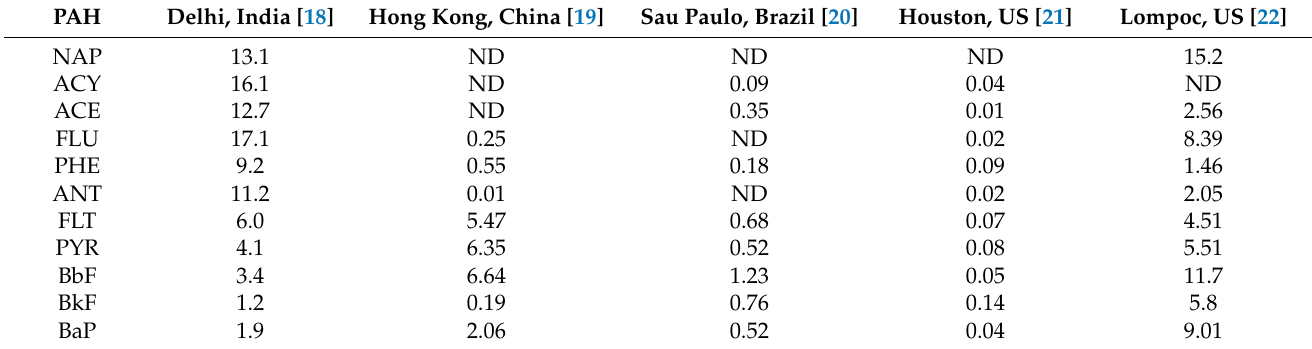
Table 1. Comparison of polycyclic aromatic hydrocarbon concentrations in different regions (ng/m 3